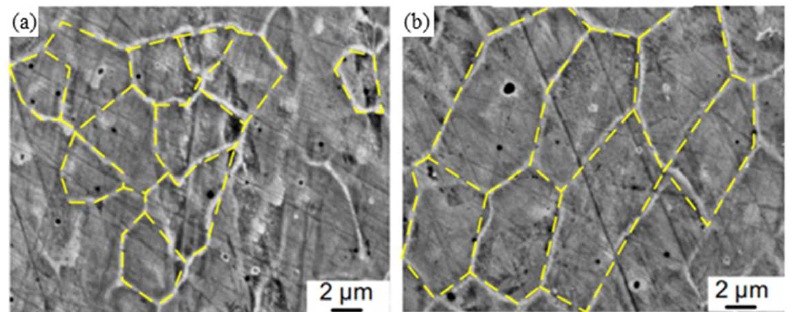
Figure 10. Effects of ultrasonic vibrations on the grain size of AISI 630 thin walls fabricated by LENS: ( a ) with ultrasonic vibrations; ( b ) without ultrasonic vibrations [68].